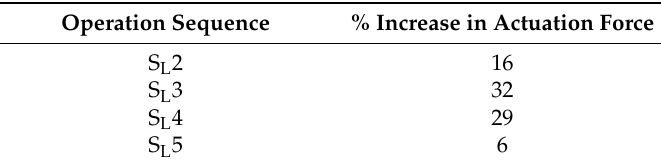
Table 2. Percentage increase in actuation force of slender electrode sequences with respect to a square